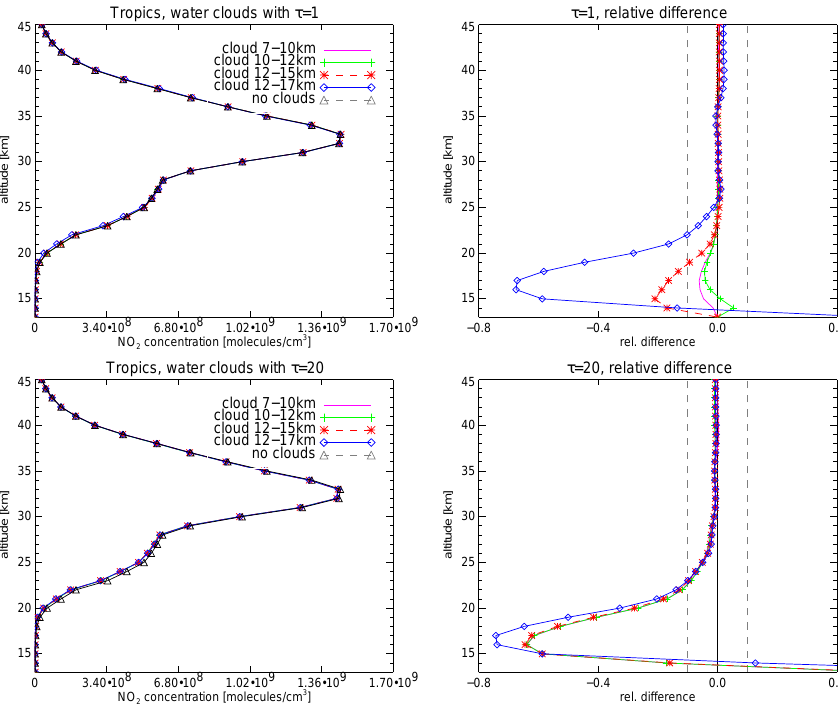
Fig. 5. Influence of water clouds with an optical thickness of 1 (upper panels) and 20 (lower panels) on the retrieved results a the tropics example (SZA=35 ◦ ), 18 June 2005. Left panels show the NO 2 profiles retrieved for different clouds. Right panels show corresponding relative